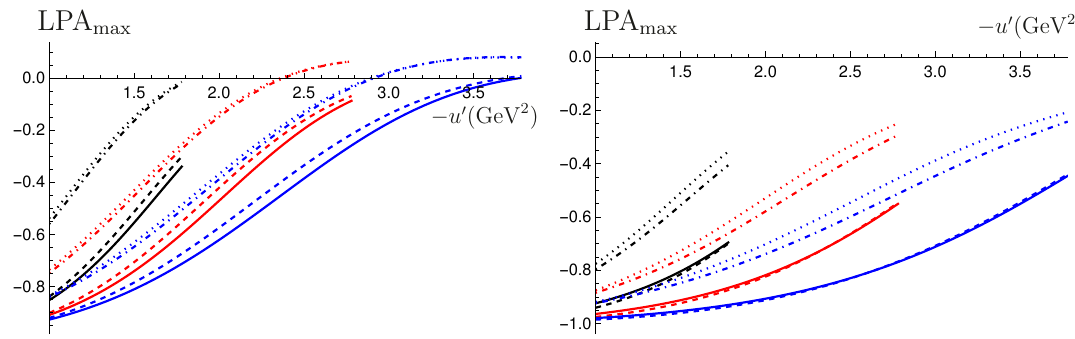
Figure 36 . The LPA at the fully-differential level for π + ( π − ) is shown as a function of ( − u 0 ) on the left (right) for different values of M 2 . The black, red and blue curves correspond to γπ = 3 , 4 , 5 GeV 2 respectively, and S = 20 GeV 2 . The dashed (non-dashed) lines correspond M 2 γN γπ to holographic (asymptotic) DA, while the dotted (non-dotted) lines correspond to the standard (valence)